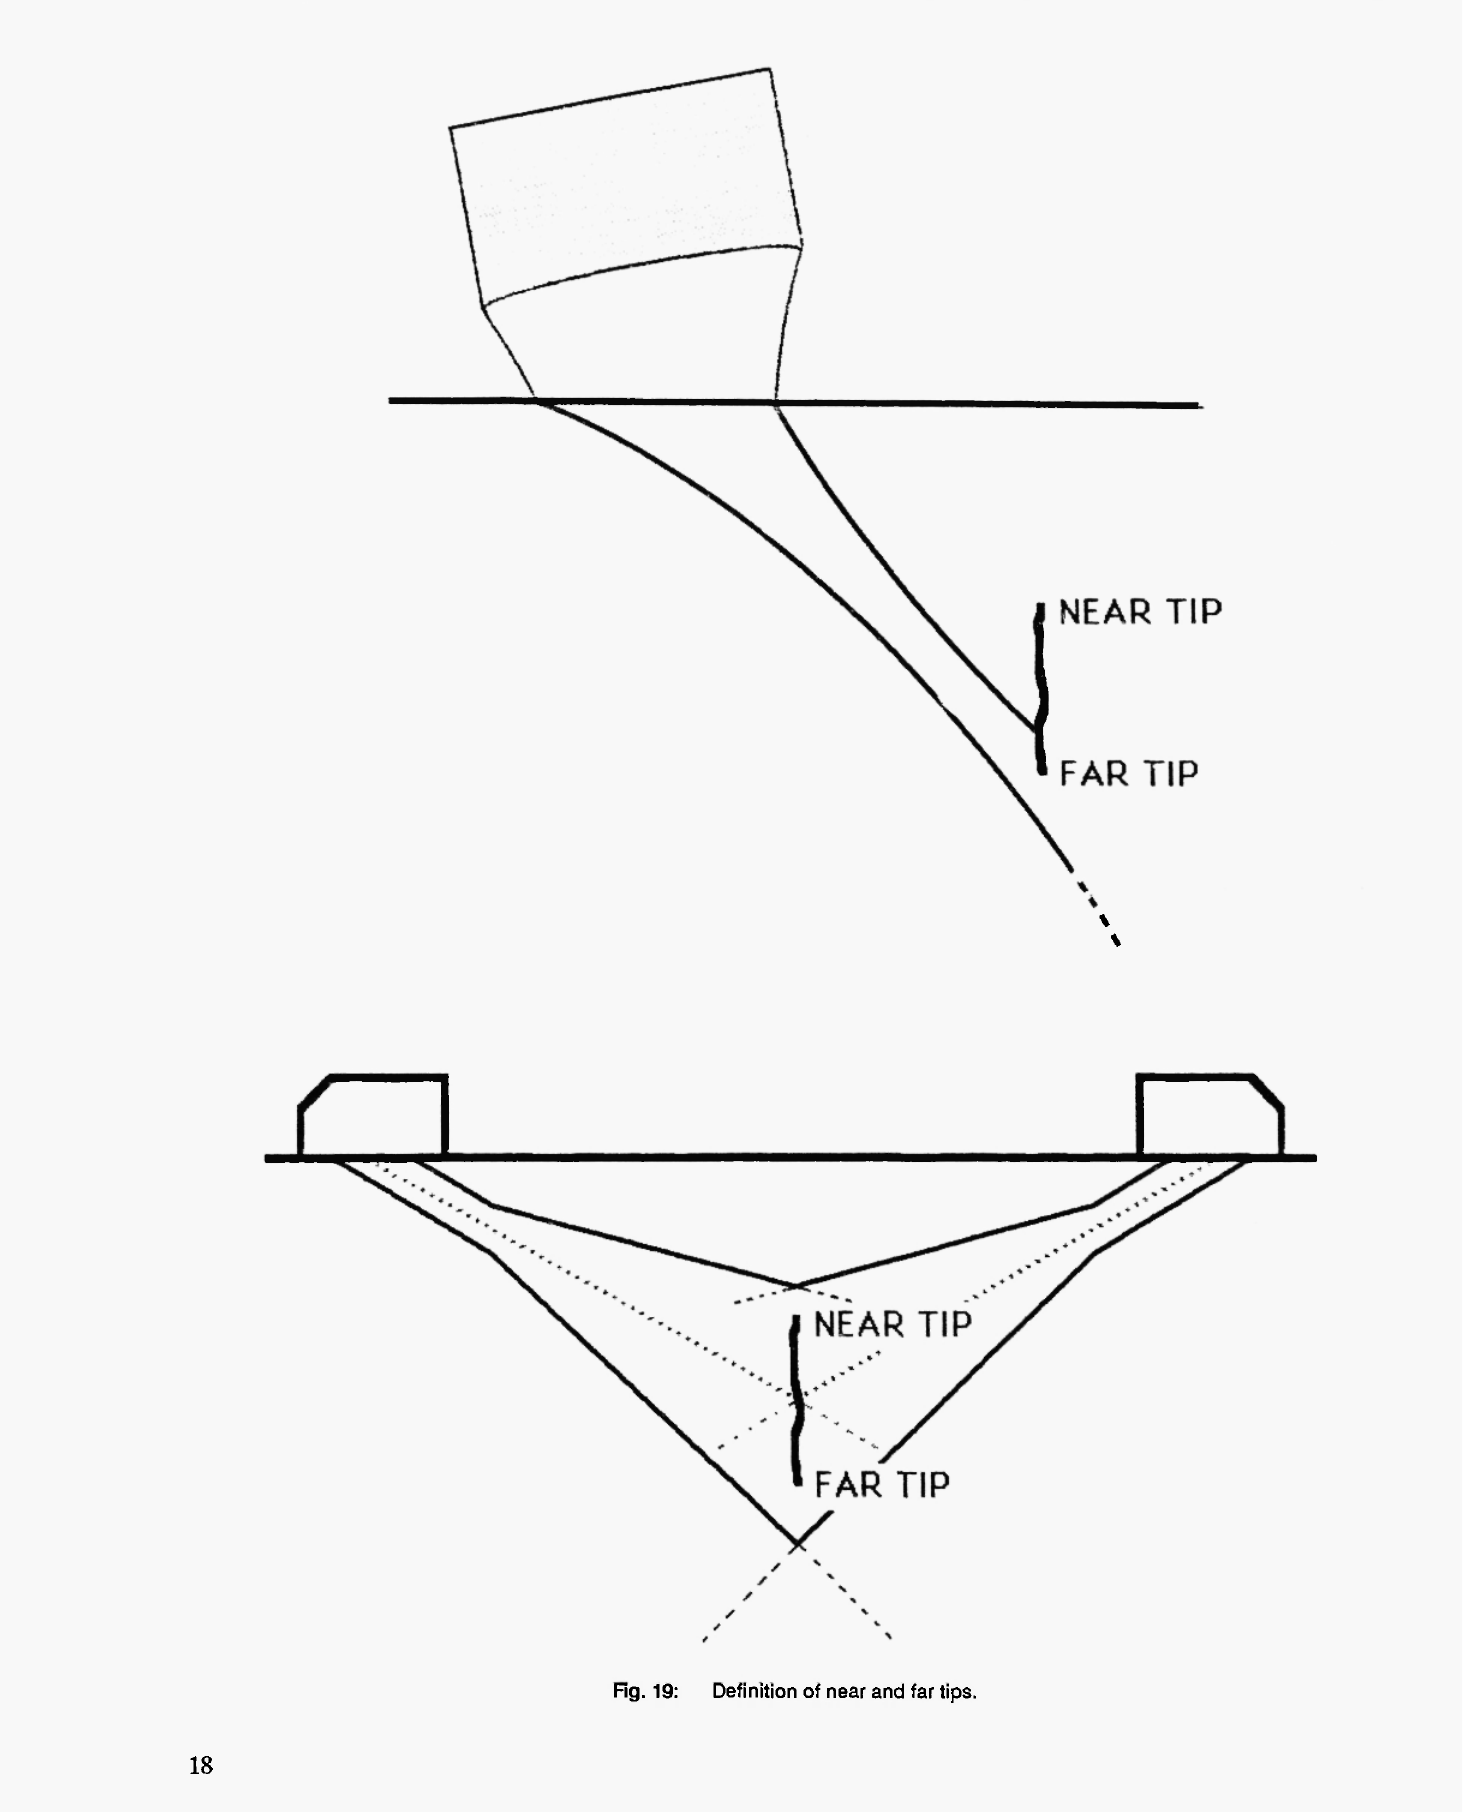
Fig. 19: Definition of near and far